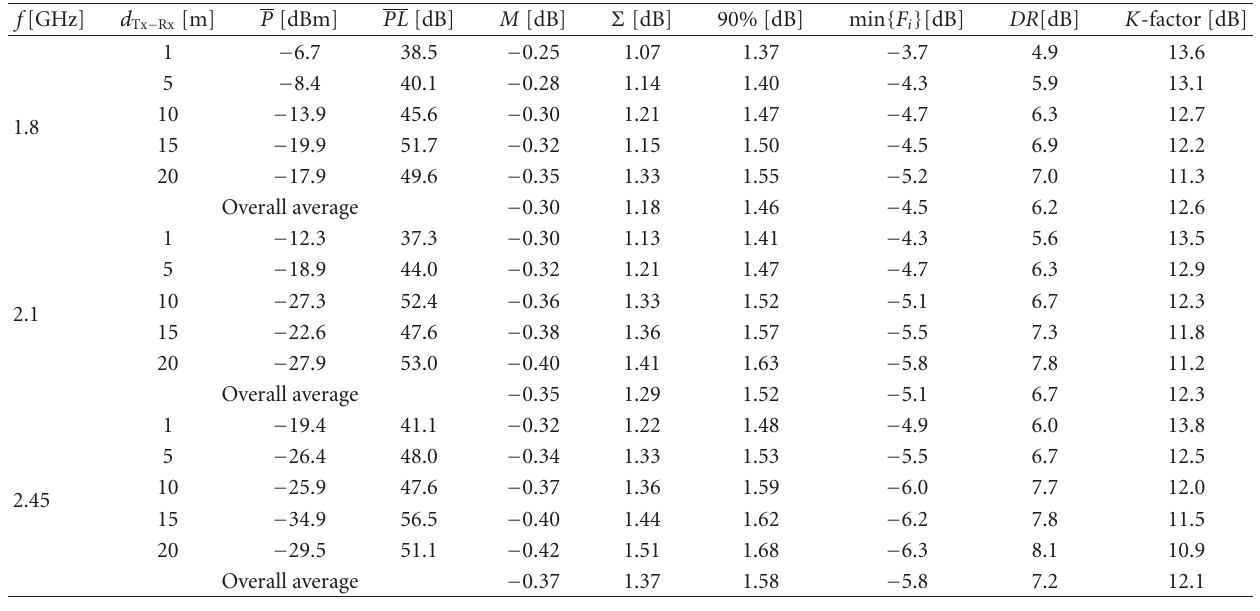
Table 2: Fading statistics along the aisle of the Boeing 737–400.